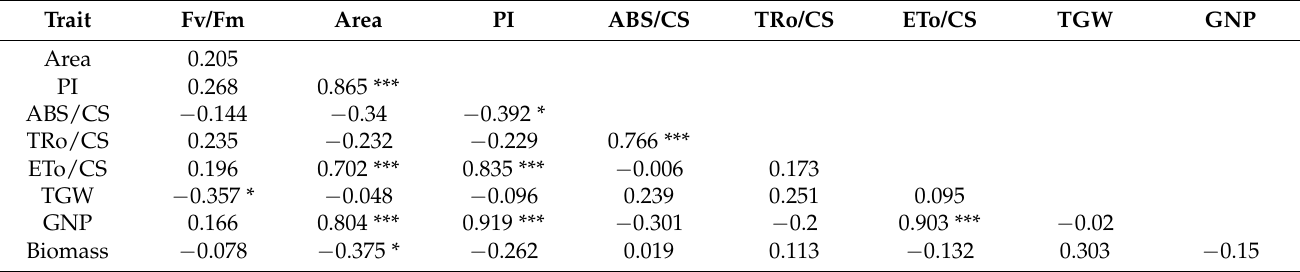
Table 2. Correlation coefficients between variables for chlorophyll fluorescence and yield elements of barley DH lines.